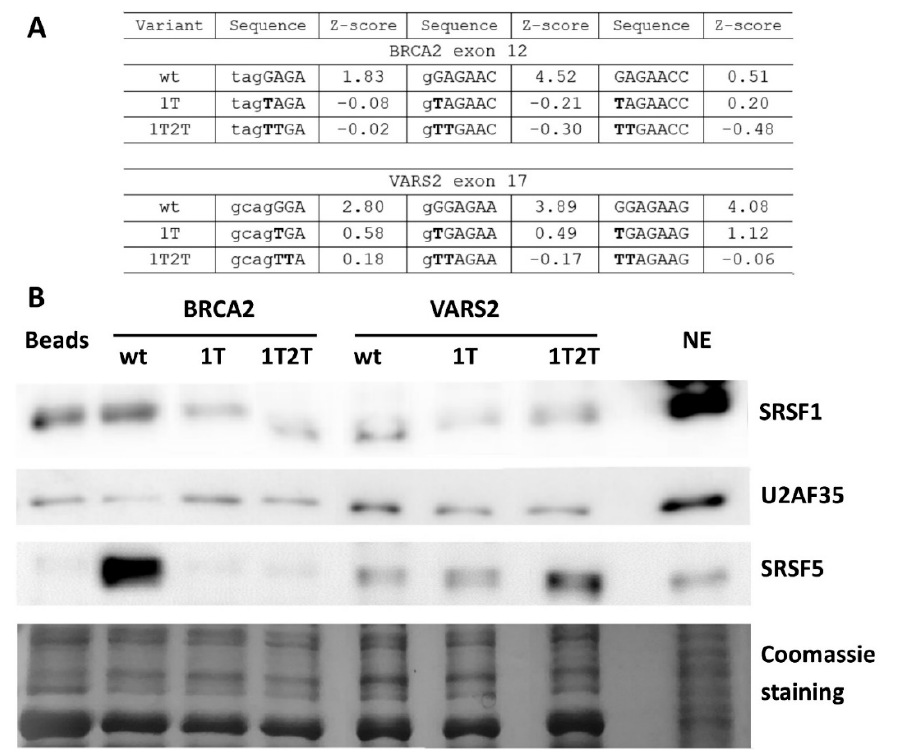
Figure 6. Affinity purification of RNA binding proteins (RBPs) of in vitro transcribed RNAs. ( A ) Table shows SRSF1 binding motif weakening in 1T and 1T2T variants compared to the wild-type construct via their Z-scores. Values correspond to the binding affinity of SRSF1 to each 7-mer [31], and 7-mers with the highest Z-score in analyzed sequences are shown. ( B ) Western blot analysis after the affinity purification of RNA-binding proteins is shown. Beads alone (Beads) and the HeLa nuclear extract (NE) sample were used as a control. Western blot images and Coomassie gel staining are representative figures in three independent experiments.